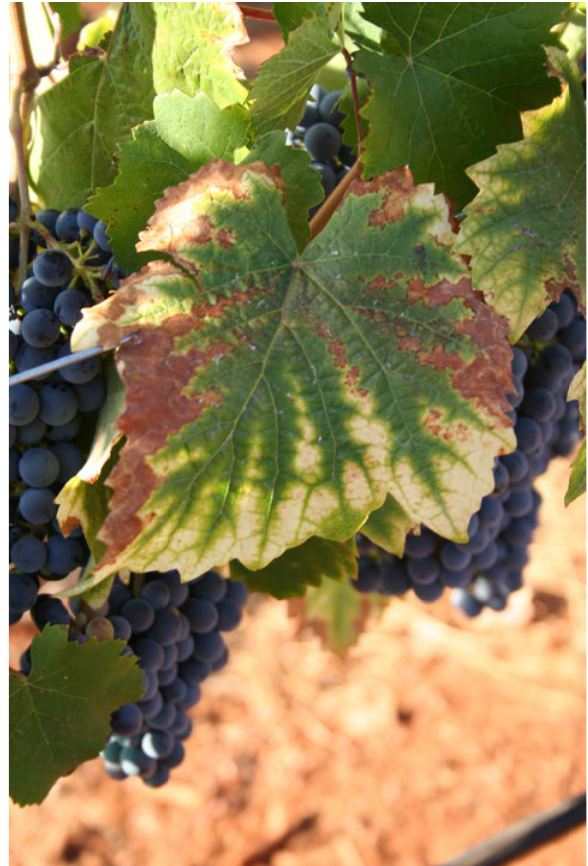
Figure 6. Magnesium deficiency is associated with a typical chlorosis or, in red cultivars, anthocyanins accumulation, that resemble GLSD symptoms. The chlorosis develops in the interveinal areas of the leaf blade with a more regular pattern than GLSD, and typical pointed ends shape. A ne- crosis can also